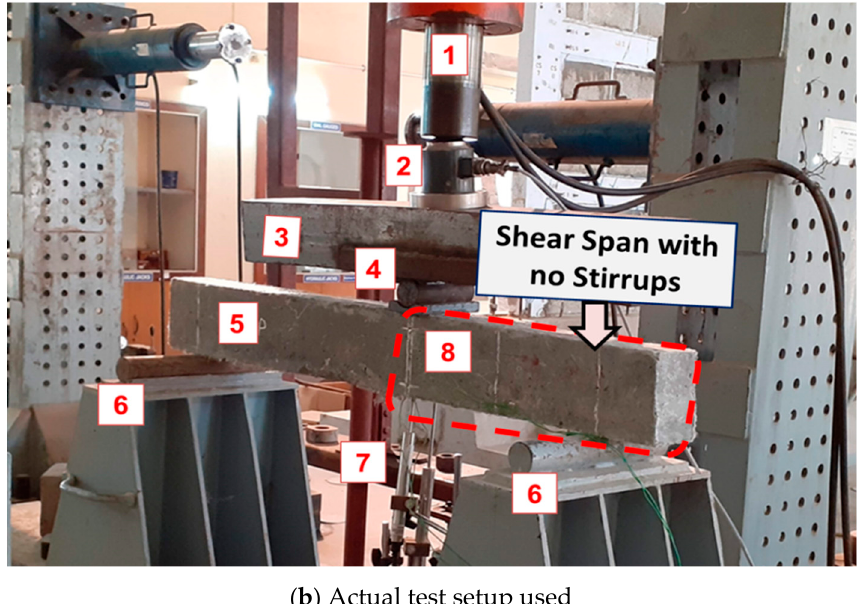
Figure 1. ( a ) Sectional details of the test specimen, ( b ) experimental test setup. Components: 1. A 500 kN Hydraulic Jack, 2. Load Cell, 3. Spreader Beam, 4. Load Point, 5. Test Specimen, 6. Supports, 7. LVDTs for Displacement Measurement and 8. Strain Gauges.